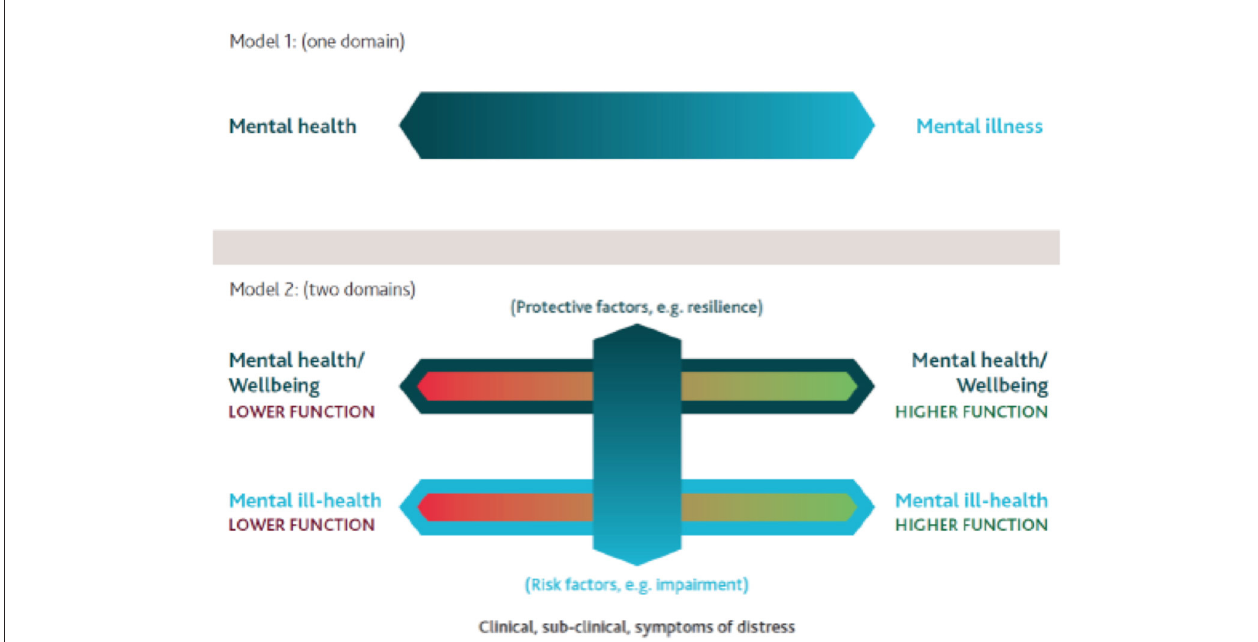
FIGURE 1 | Two-domain-model of mental health. Modified from (Boyd-MacMillan and DeMarinis, 2020).